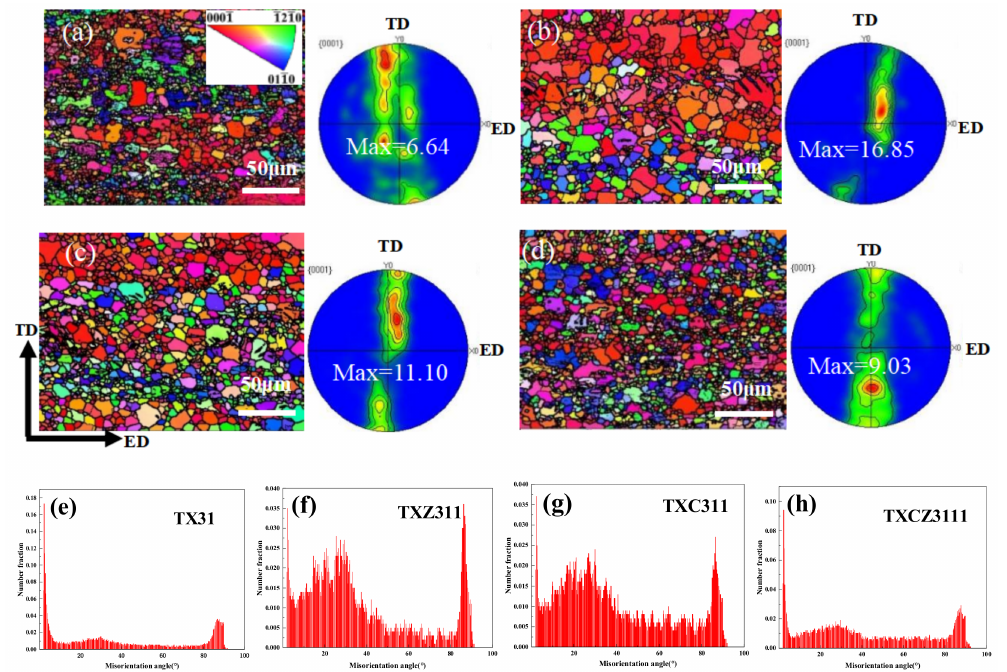
Figure 5. EBSD IPF maps and pole figures of the four extruded alloys, ( a , e ) TX31; ( b , f ) TXZ311; ( c , g ) TXC311; ( d , h ) TXCZ3111; ( e , f , g , h ) Misorientation angle distribution of four extruded